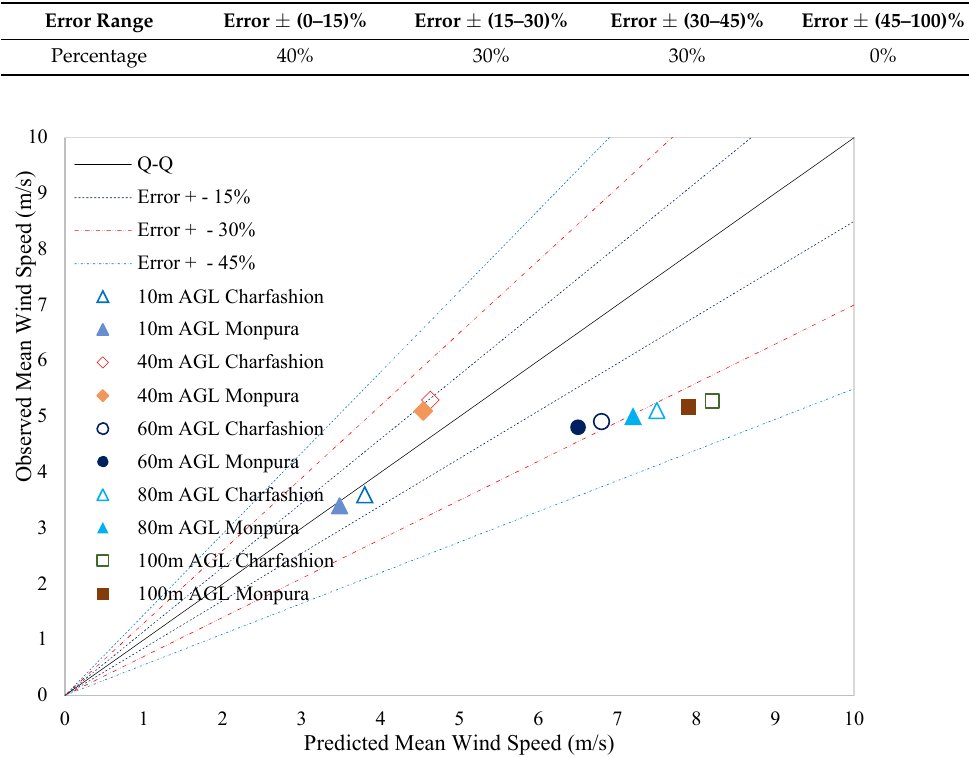
Table 10. Statistical tests for the two prospective coastal areas of Bangladesh.